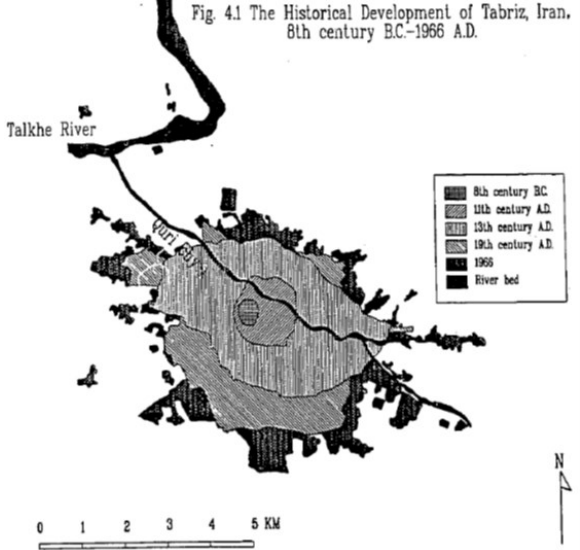
Figure 6. The Historical Development of Tabriz, Iran. 8th century B.C. – 1966 A.D. (Azimi, 1995, p. 70).